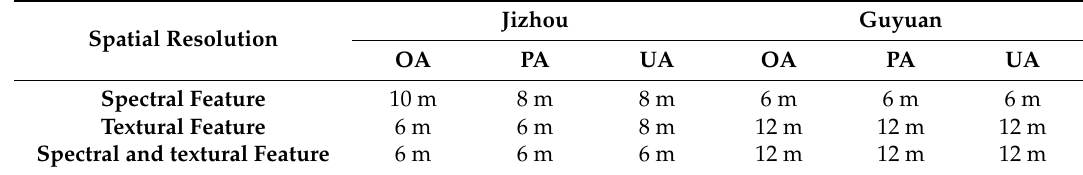
Table 4. Spatial resolution with the highest overall accuracy (OA), producer’s accuracy (PA) and user’s accuracy (UA) from different feature